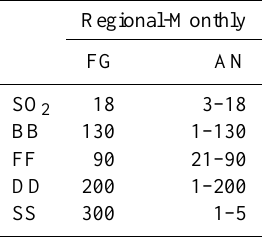
Table 4. Regional-monthly emission errors in % for the FG and the range of AN errors between the four experiments.